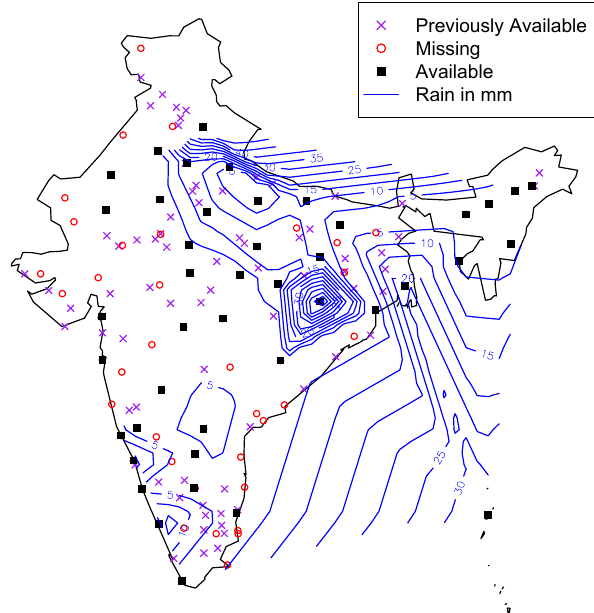
Figure 1. Observed Indian rainfall (in mm) on 25 August 2012, shown in contours. Markers indicate NCDC NOAA data status of individual